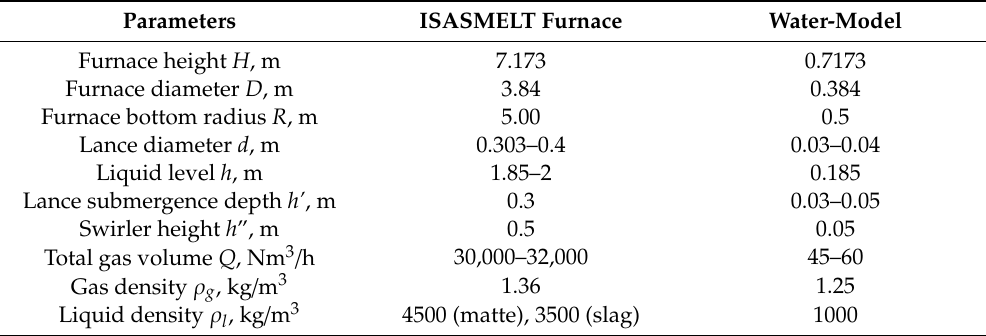
Table 1. Parameters of water-model and ISASMELT